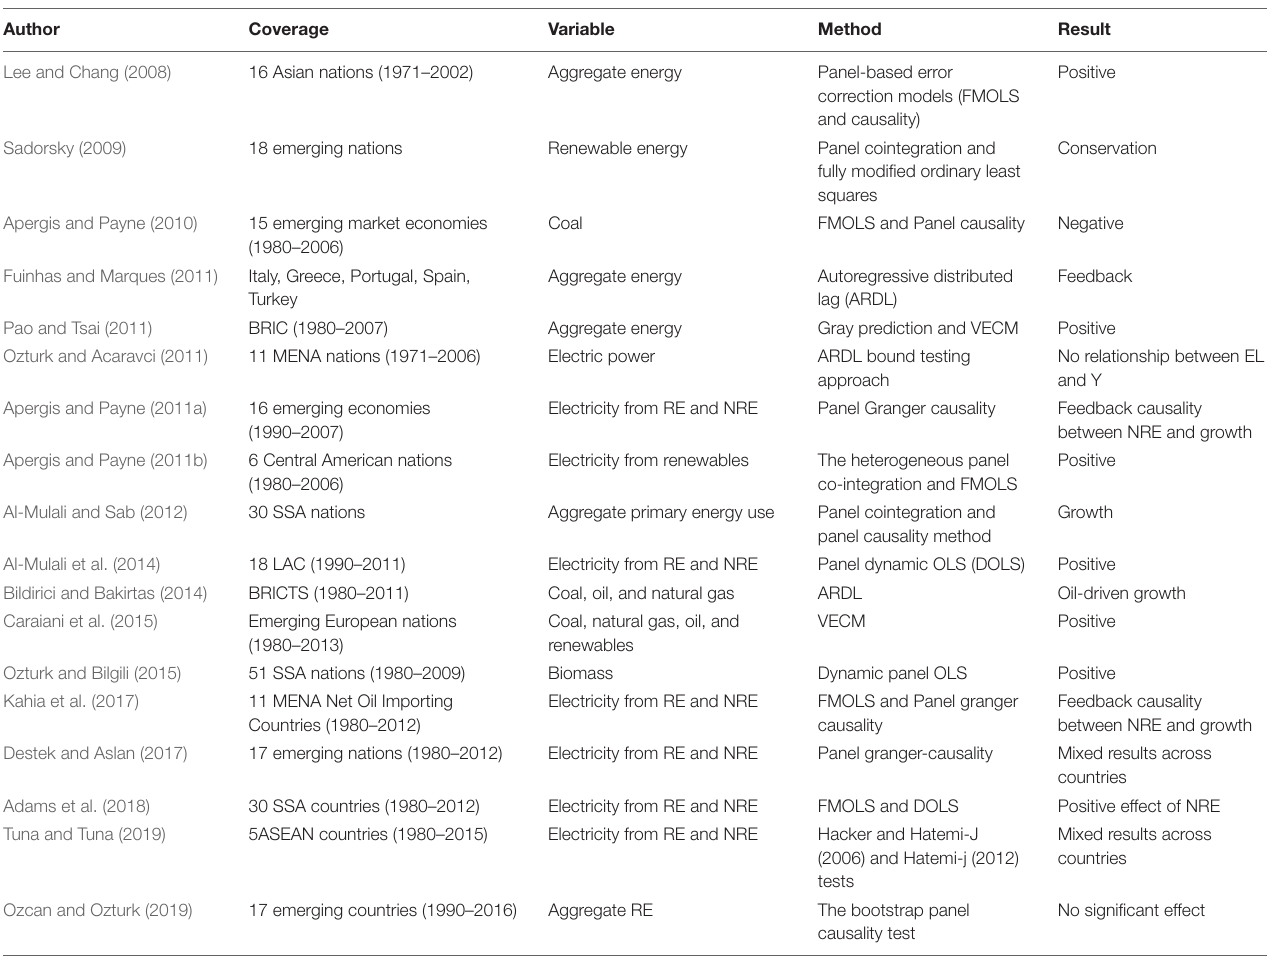
TABLE 1 | Extant literature on energy and economic growth